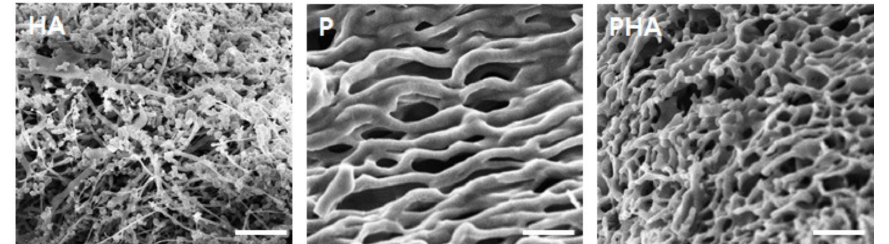
Figure 4. SEM images of freeze-dried HA (1.0 wt.%), P (12.0 wt.%), and PHA (12.0 wt.%) in DW. The scale bars are 50 µ m.